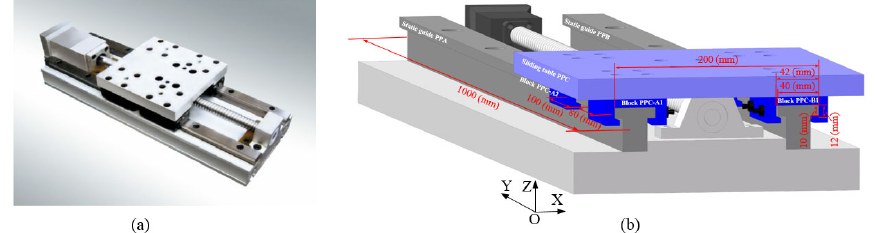
Figure 12. Sliding workbench. ( a ) A real sliding workbench , ( b ) The sliding workbench model of this case study.